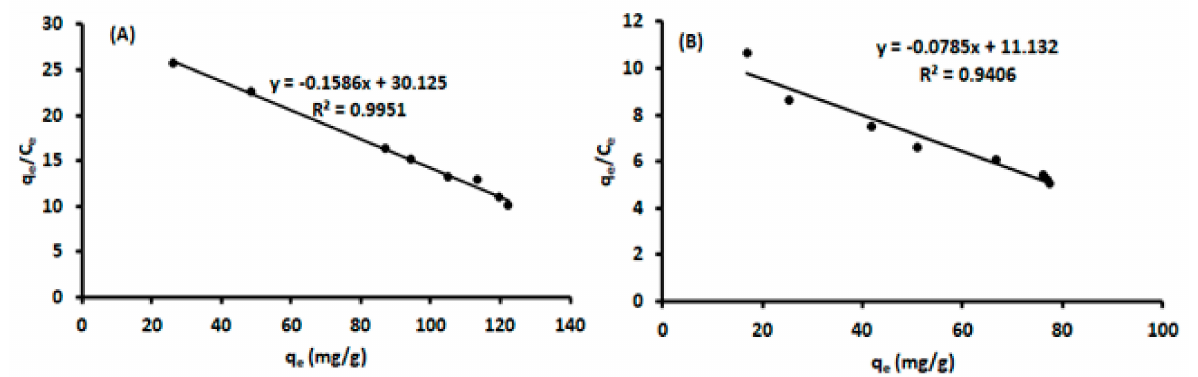
Figure 9. Scatchard plot of ( A ) ACT on MIP and ( B ) NIP Experimental parameters: initial concentration, 1–20 mg/L, mass of adsorbent, 23 mg; contact time, 12 min, sample pH; sample volume, 100